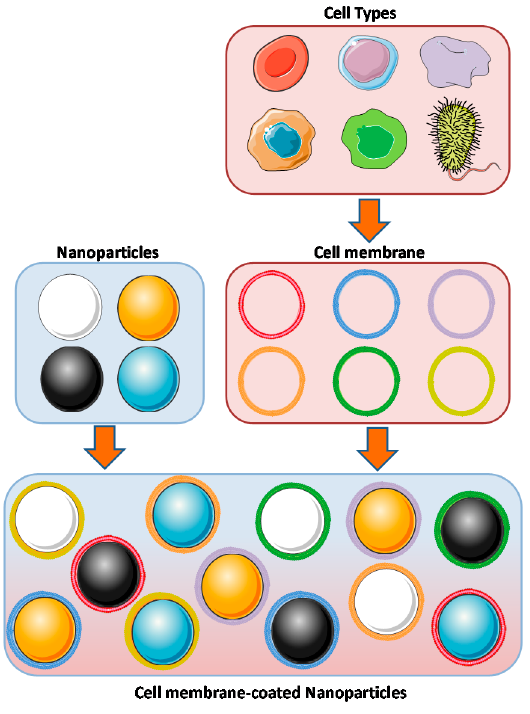
Figure 2. Cell membrane coated nanoparticles. Different types of cells have been used to coat over nanoparticles. Each type of cell membrane has different functions and properties depending on the required application.